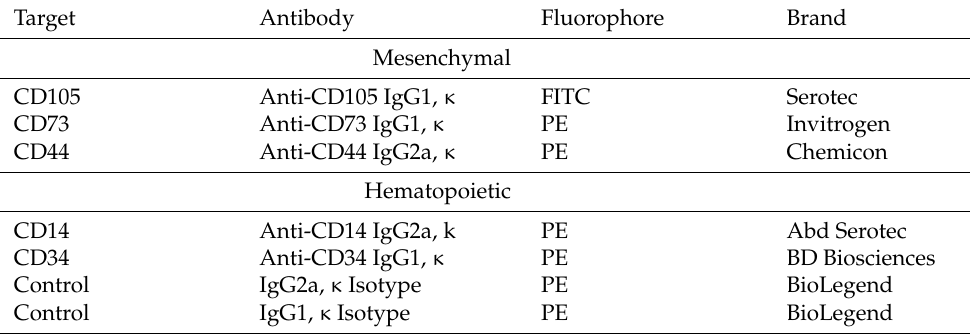
Table 1. Flow cytometry targets and